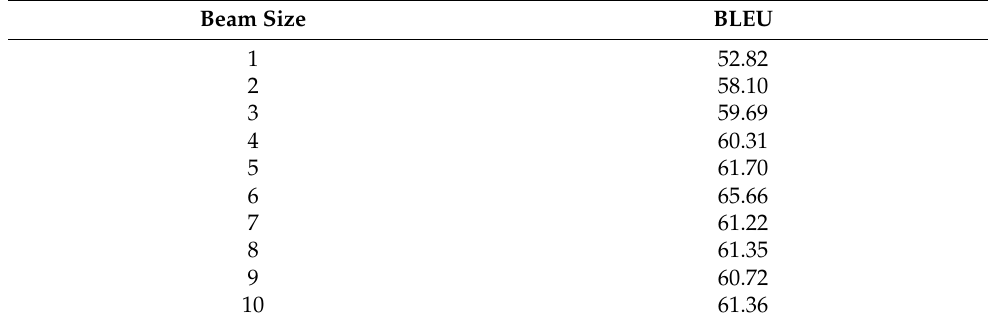
Table 13. Change in BLEU Score According to Beam